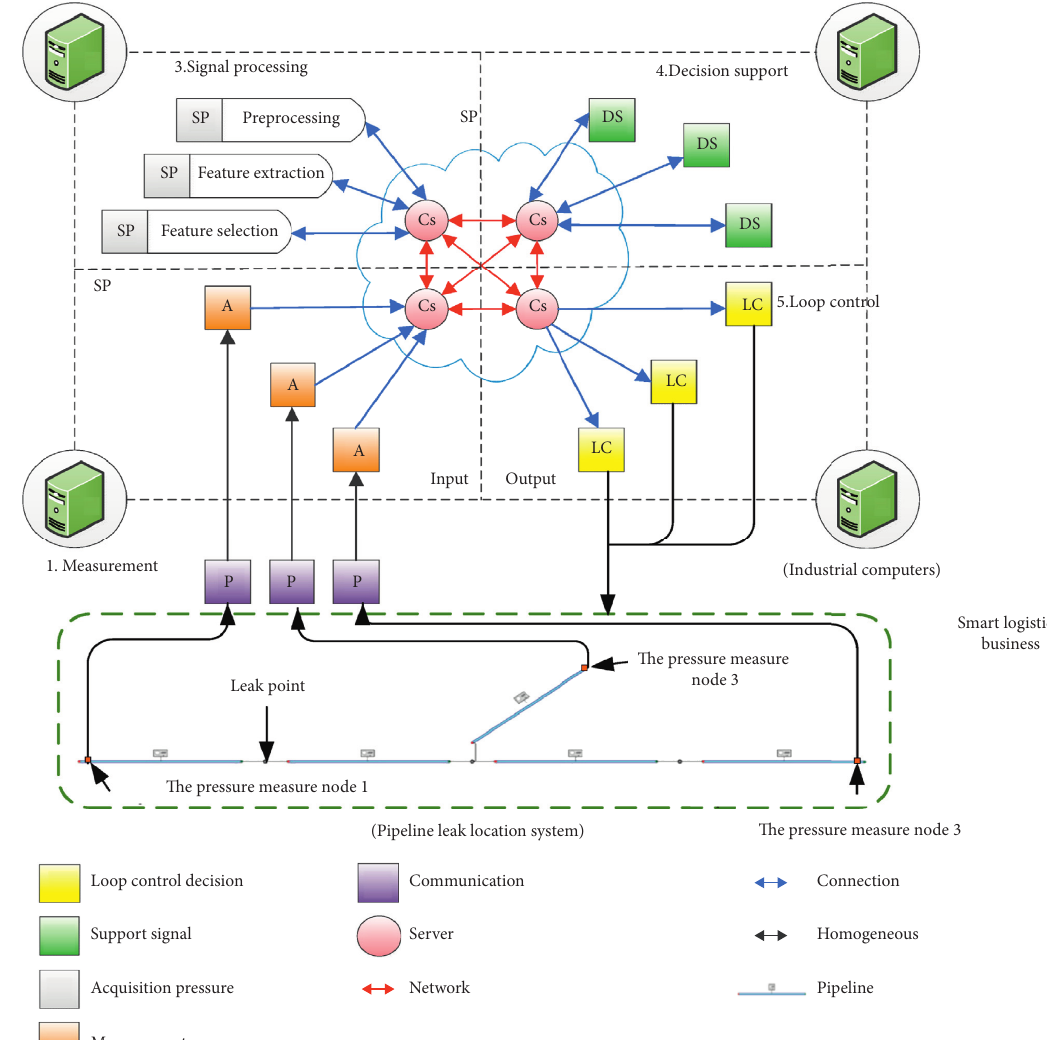
Figure 3: Smart logistics